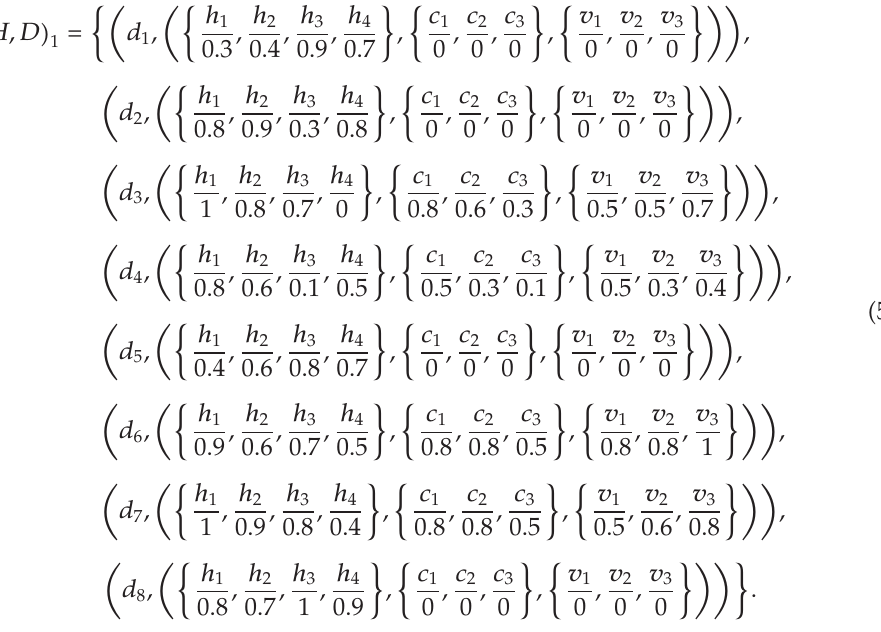
Table 3: Score table: U − fuzzy soft multiset part of (cid:5) H,D (cid:6) . 1 Row-sum (cid:5) r i (cid:6) Column-sum (cid:5) t i (cid:6) Score (cid:5) S i (cid:6) h 1